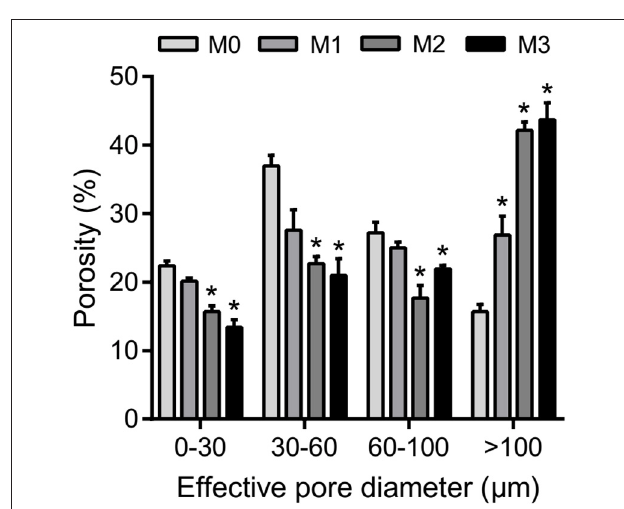
FIGURE 2 | The pore size distribution in soil macroaggregates under manure treatments. Bars with * in the same pore diameter indicate significant differences ( P < 0.05) between manure additions and the M0 treatment, as revealed by one-way ANOVA with Bonferroni’s post-hoc test. M0, no manure; M1, low manure; M2, high manure; M3, high manure plus lime.